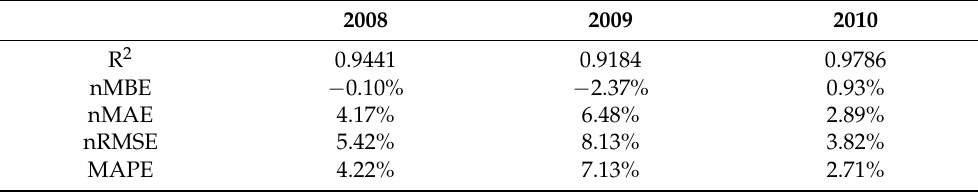
Table 2. Performance of the average daily soil moisture predicted from 100 neural network models that each of them continuously predicted soil moisture based on the hesternal